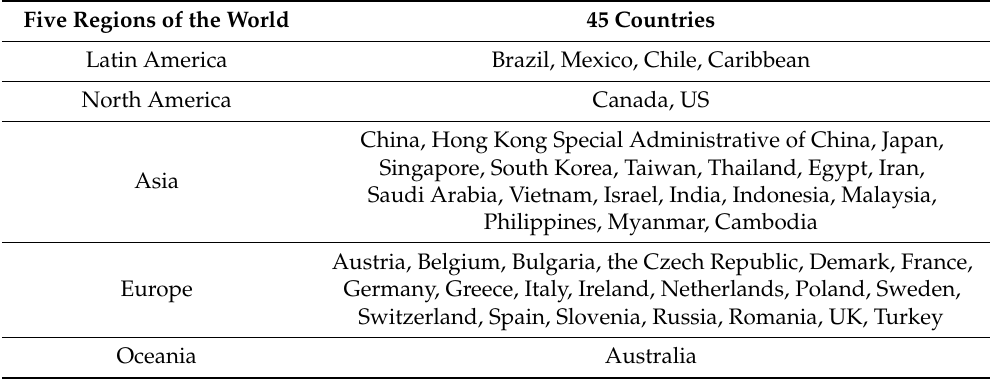
Table 1. Distribution of included studies (alphabetic order).